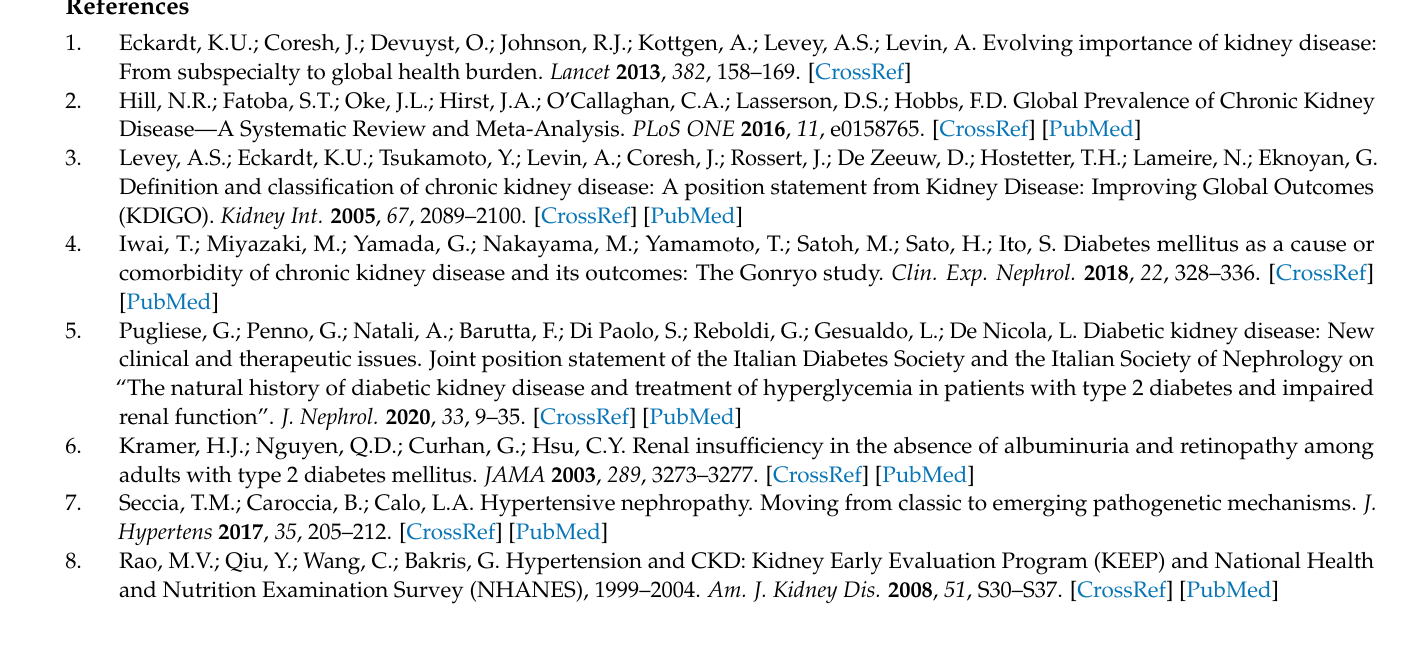
Table S3: Results of the Mendelian Randomization (MR) analysis for Myristoleic acid (14:1) and kidney function. Table S4: Results of the Mendelian Randomization (MR) analysis for Oleic acid (18:1) and kidney function. Table S5: Results of the Mendelian Randomization (MR) analysis for Palmitoleic acid (16:1) and kidney function. Table S6: Results of the Mendelian Randomization (MR) analysis for alpha-linolenic acid (18:3) and kidney function. Table S7: Results of the Mendelian Randomization (MR) analysis for Eicosapentaenoic acid (20:5) and kidney